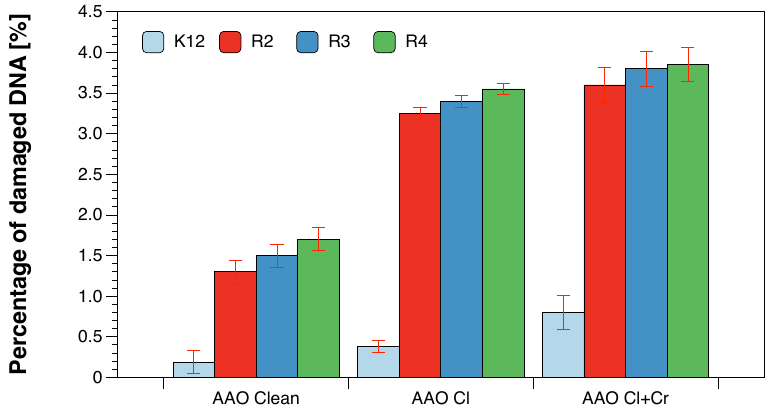
Figure 4. Percentage of plasmid DNA recognised by Fpg enzyme ( y -axis) with model bacteria, K12, and R2–R4 strains ( x -axis). Each experiment was performed independently in three replications (n =